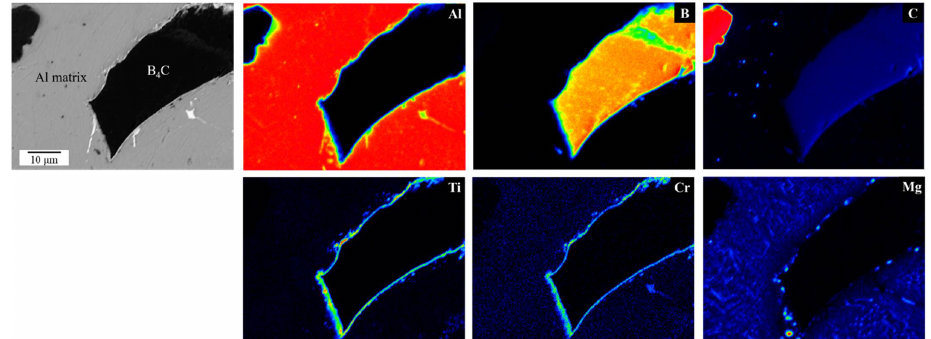
Figure 3. Element mapping images of the stir-cast 5 vol.% B 4 C/Al6061 composite observed using an electron probe microanalyzer. Figure 4 is a schematic diagram showing the microstructure of the B 4 C/Al6061 com- posites manufactured by stir casting and hot rolling. As confirmed in the three-dimen-